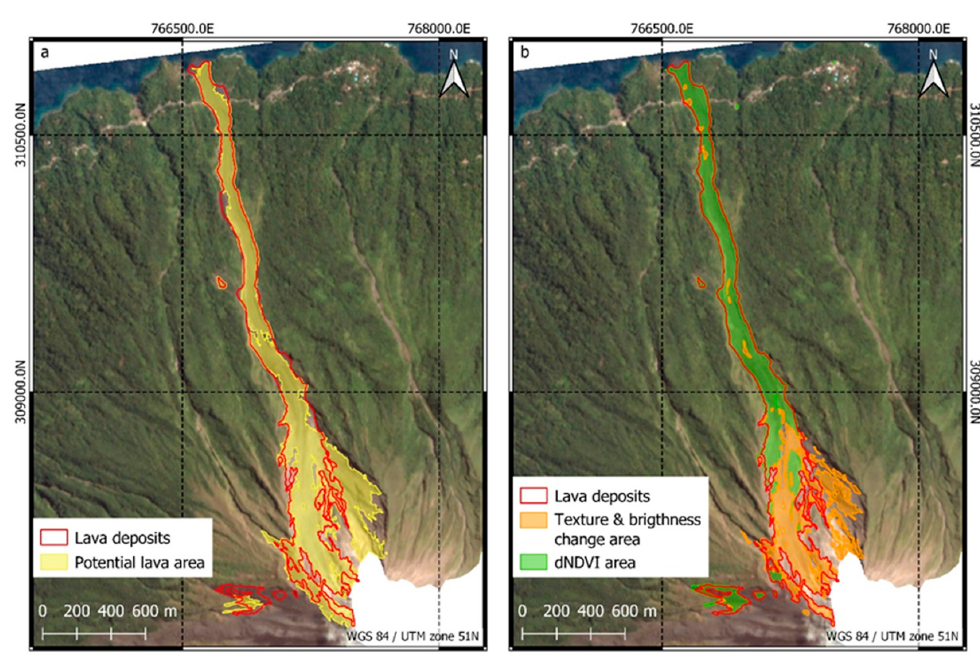
Figure 6. ( a ) Potential lava areas based on distance from the runoff model (derived from TanDEM-X DEM). All areas in the “potential lava area” class are within 45 m of the nearest point on the extracted drainage flow. ( b ) Change areas within vegetation ( dNDVI ) and change areas based on texture (GLCM) and brightness change. Areas in the change area class were classified based on GLCM and brightness thresholds. Based on the dNDVI area, region-growing modelling is performed into the “change area”. Background: PlanetScope post-scene (4 May 2019).